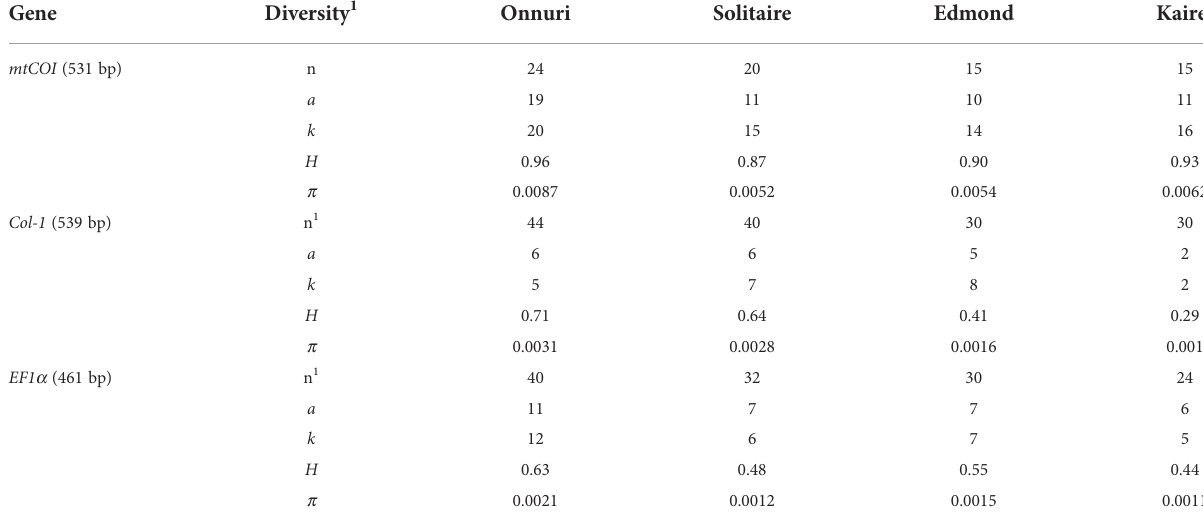
TABLE 3 Genetic diversity indices of host populations on the CIR.